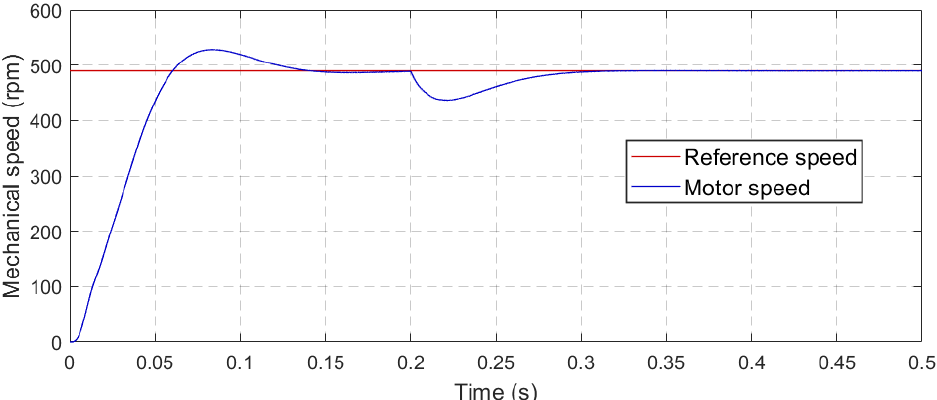
Figure 21. Reference speed and measured speed before and after a rated load torque step is applied at t = 0.2 s.